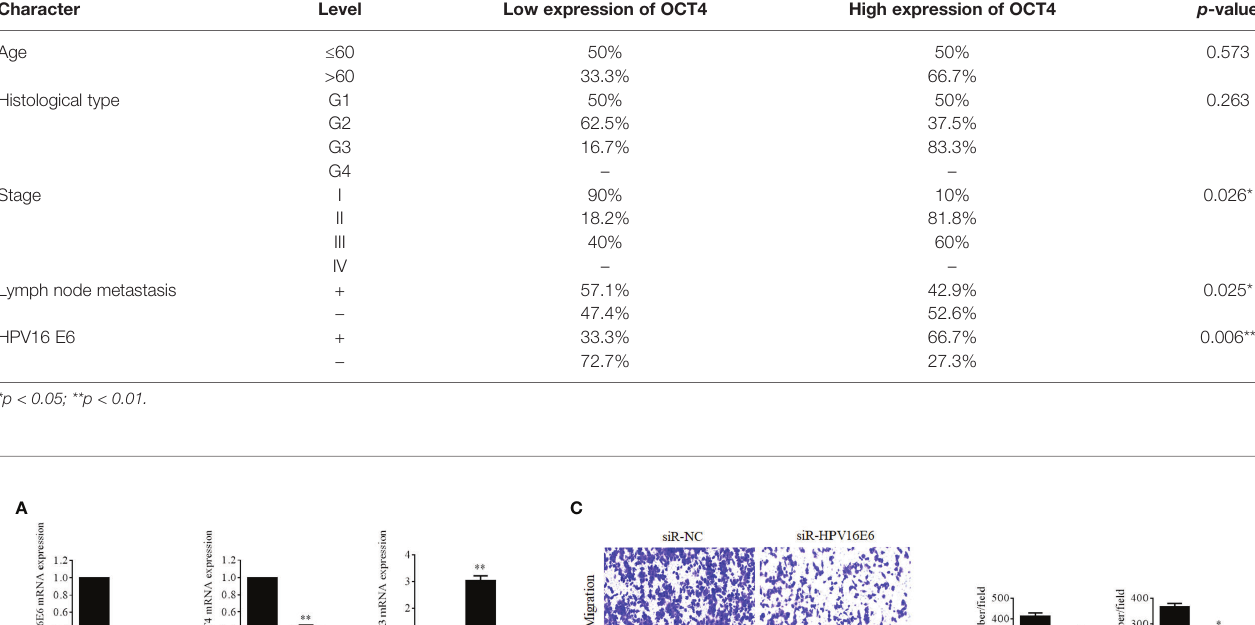
TABLE 3 | Association between OCT4 protein expression and clinicopathological features in cervical cancer patients.